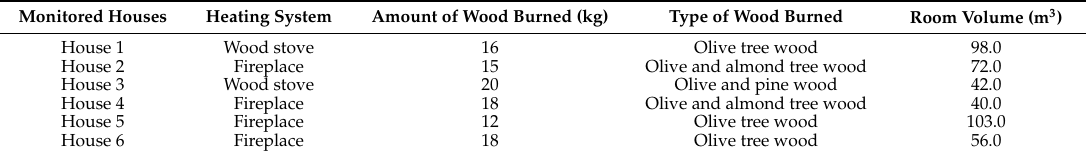
Table 1. Type of heating systems used, amount and type of wood burned and room volume for each